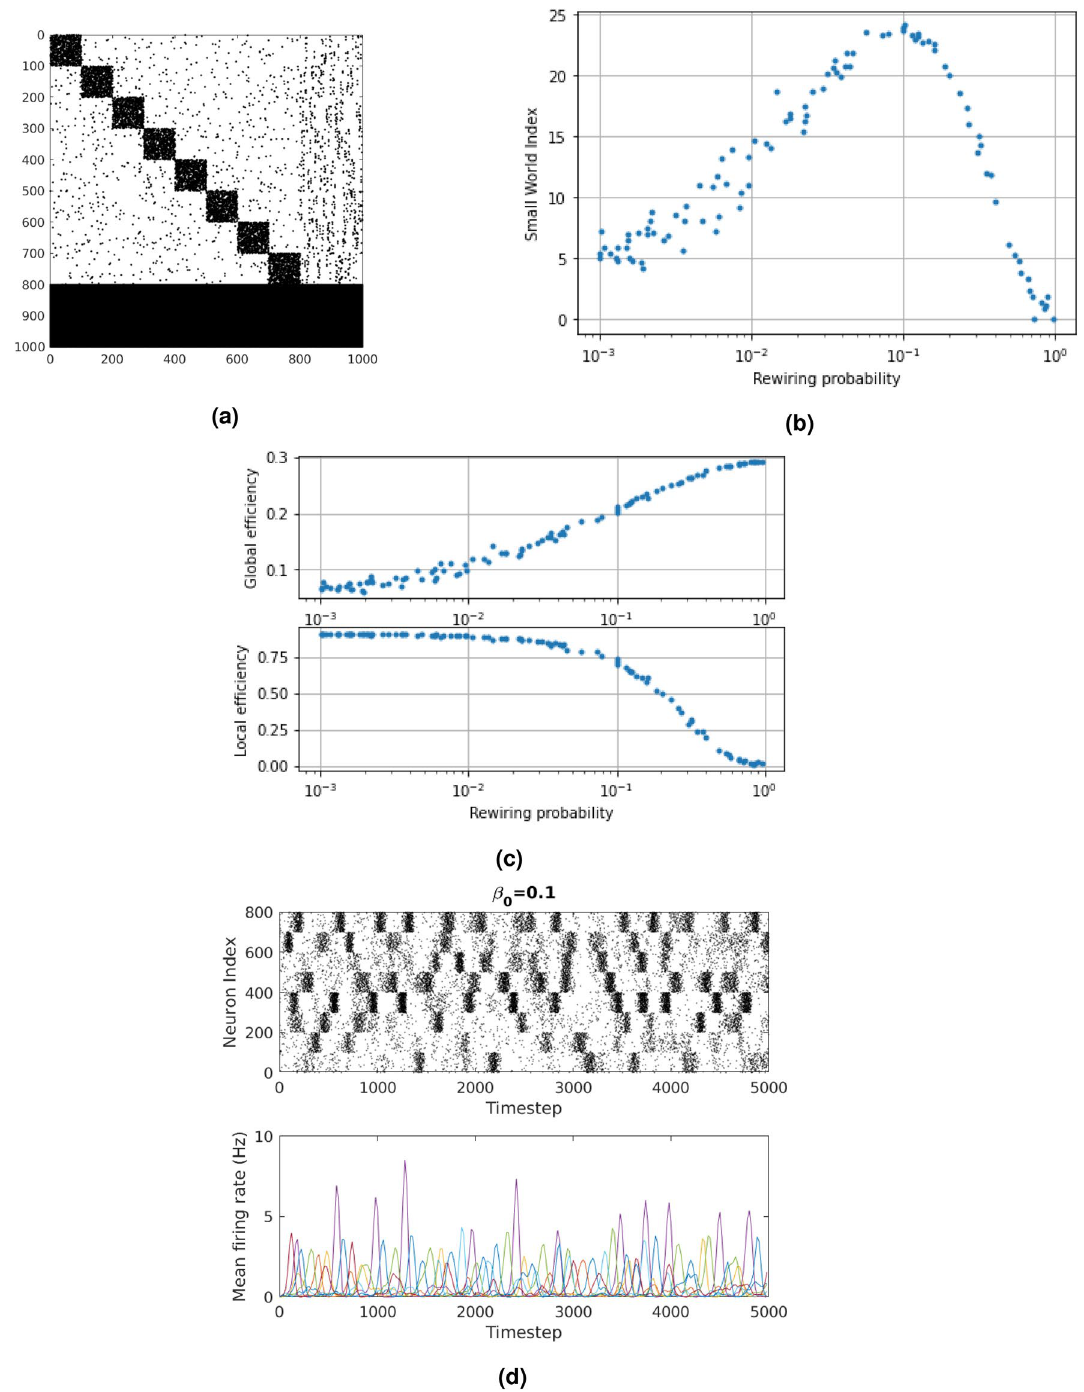
Figure 1. ( a ) Modular SWN with rewiring probability of 0.1 (black dot shows connection between neuron indexes). ( b ) Blue dots show varying rewiring probability and impact on the SWI. ( c ) Blue dots show varying rewiring probability and impact on the GE (top) and the LE (bottom). ( d ) Modular SWN MFR. Black dot shows fired neuron. Different colours show MFR of different modules. These will be referred as the raster plot one with more biological plausibility (since it experiences a much higher SWI) than the other ones, irrespective of the number of nodes. With both types of rewiring probabilities kept constant ( β 0 = 0.1, β 1 = 0.1) the adjacency matrix of a modu- lar SWN with 800 excitatory (labelled 1–800) and 200 inhibitory neurons (labelled 801–1000) is constructed (Fig. 1a). Therefore, there are four types of neuron connections (which can be seen by breaking up the adja- cency matrix into four constituent matrices): (1) excitatory-to-excitatory, (2) excitatory-to-inhibitory, (3)